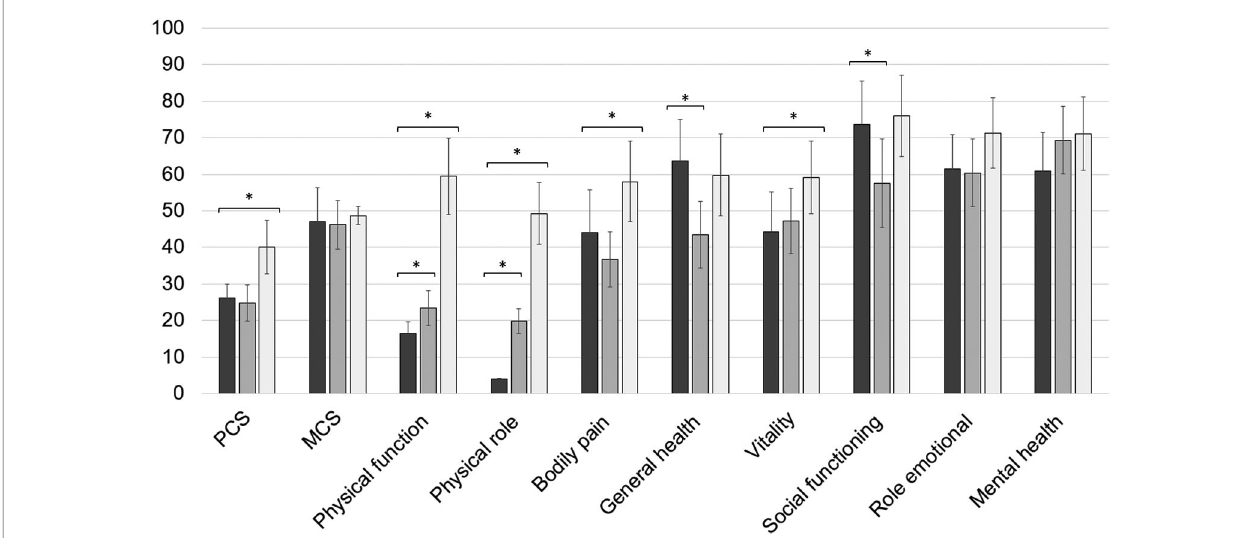
FIGURE 3 | Subdimension scores for patient-related quality of life assessed with SF-36. The results of the study cohort are shown in dark gray. For a comparison, the values of the successfully treated periprosthetic joint infection (PJI) and fracture-related infection (FRI) population are illustrated in gray and light gray, respectively. * illustrates statistical signi fi cance on a p <0.05 level determined by an independent t -test.